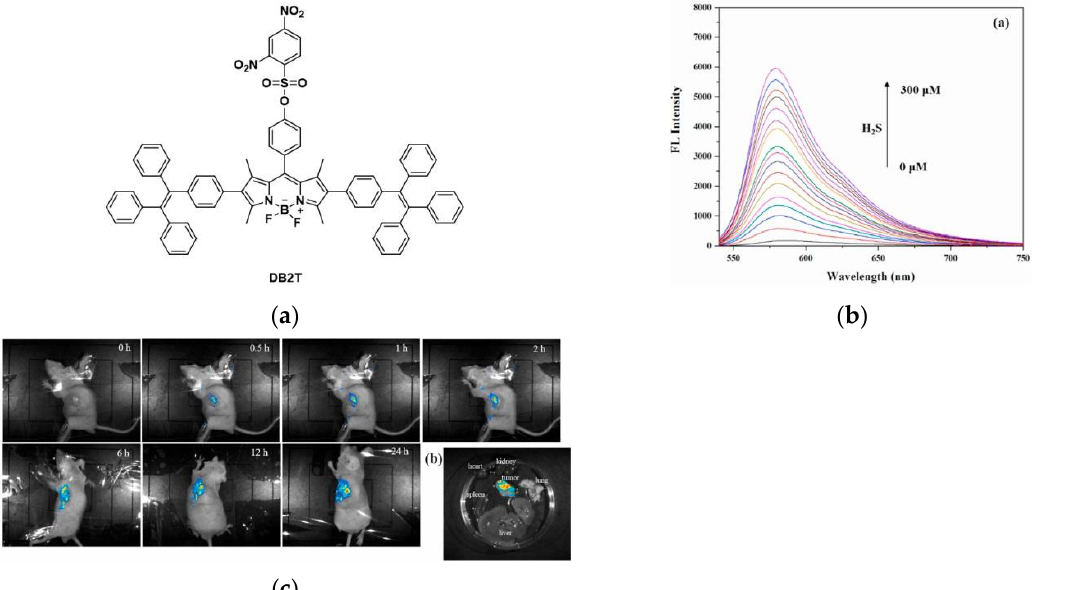
Figure 29. ( a ) Structure of probe DB2T; ( b ) fluorescence response of DB2T; ( c ) In vivo fluorescence imaging of mice bearing HCT116 tumor as well as the major organs and tumor tissue from mice. Reproduced with permission from [122]. Copyright 2021 Elsevier Ltd.